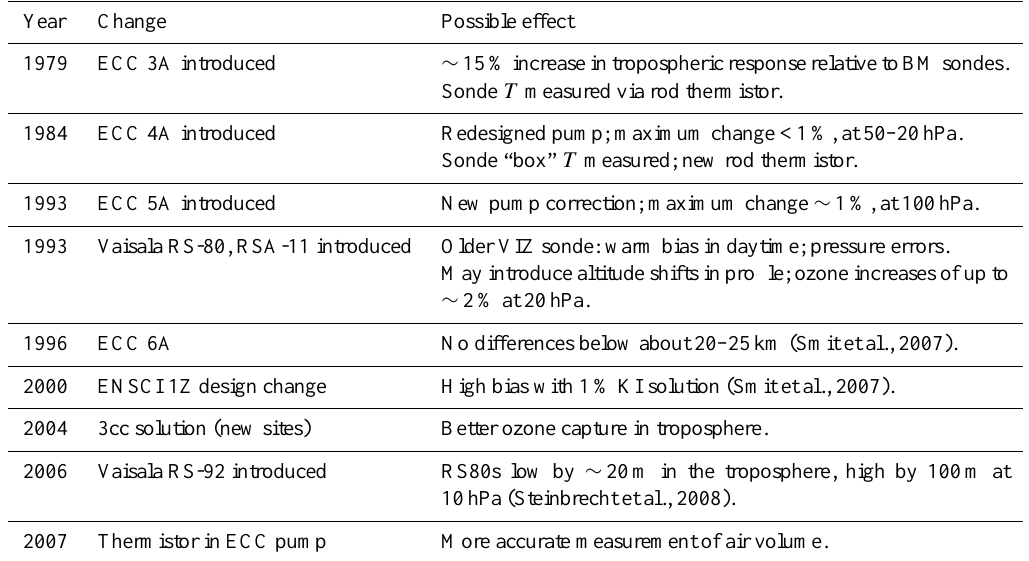
Table 2. Changes in ozonesondes and associated radiosondes in the Canadian network. Year Change Possible effect 1979 ECC 3A introduced ∼ 15% increase in tropospheric response relative to BM sondes. Sonde T measured via rod thermistor. 1984 ECC 4A introduced Redesigned pump; maximum change <1%, at 50–20hPa. Sonde “box” T measured; new rod thermistor. 1993 ECC 5A introduced New pump correction; maximum change ∼ 1%, at 100hPa. 1993 Vaisala RS-80, RSA-11 introduced Older VIZ sonde: warm bias in daytime; pressure errors. May introduce altitude shifts in profile; ozone increases of up to ∼ 2% at 20hPa. 1996 ECC 6A No differences below about 20–25km (Smit et al., 2007). 2000 ENSCI 1Z design change High bias with 1% KI solution (Smit et al., 2007). 2004 3cc solution (new sites) Better ozone capture in troposphere. 2006 Vaisala RS-92 introduced RS80s low by ∼ 20m in the troposphere, high by 100m at 10hPa (Steinbrecht et al., 2008). 2007 Thermistor in ECC pump More accurate measurement of air